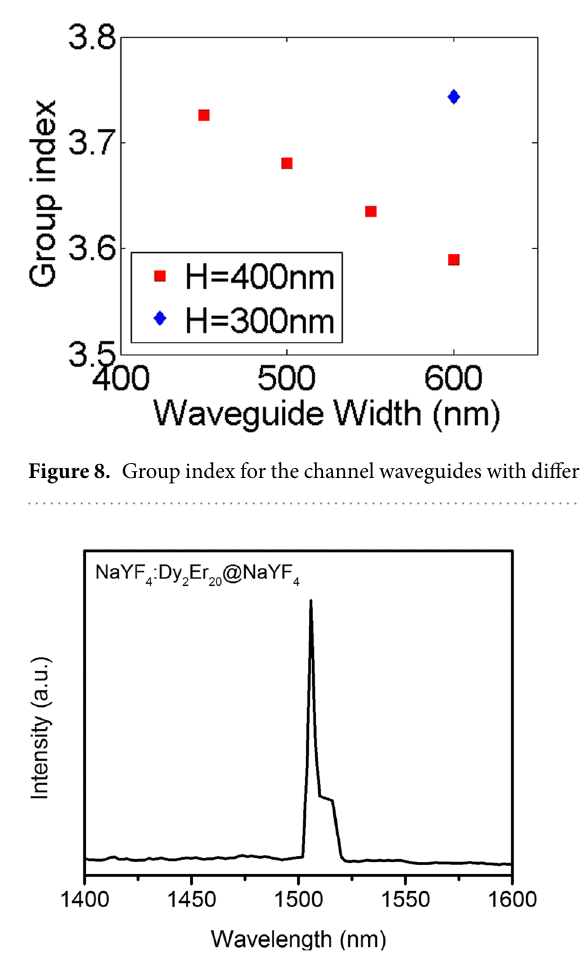
Figure 9. Photoluminescence at 1500–1525 nm when Dy-Er doped NaYF 4 core-shell nanoparticles are pumped at 1310 nm.